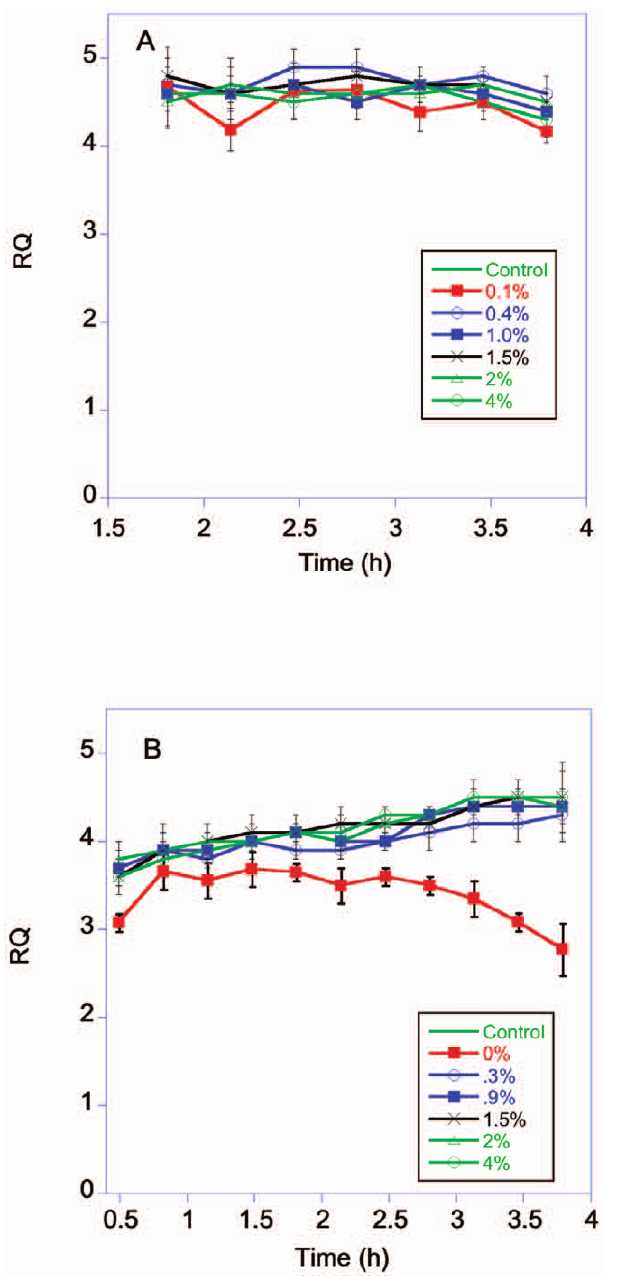
Figure 6. Cell specific metabolic rates of BY (4A) and RM (4B) grown in YP with a starting concentration of 0.1 to 4% dextrose. The cell specific metabolic rates are based on dividing the final metabolic rate measurement of yeast grown in different dextrose concentrations by the final number of cells in the sample chamber.